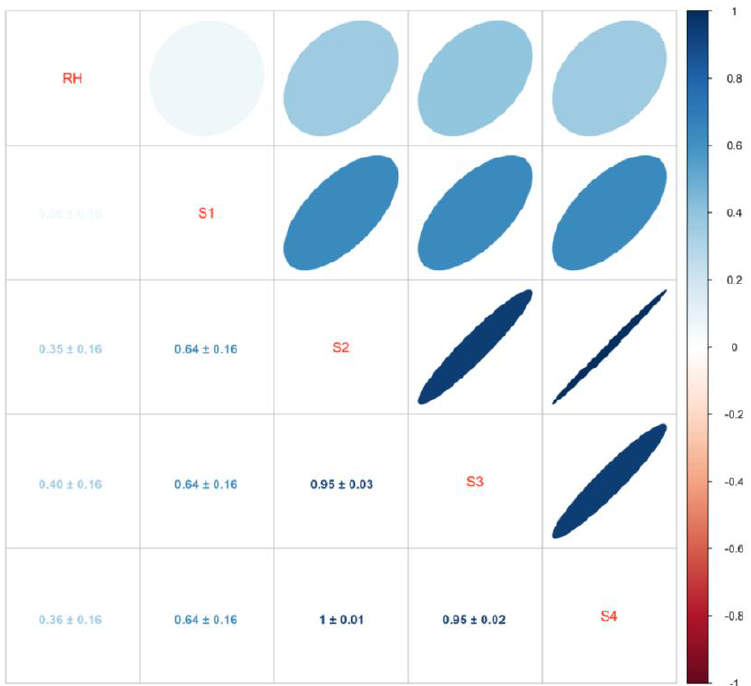
Figure 3. Correlation between relative humidity (RH) and Sensors 1–4. Values indicate mean fixed effect regression coefficients ± their 95% confidence intervals. Blue indicates positive correlation while red indicates negative correlation. Darker more elliptical shapes indicate greater correlation.